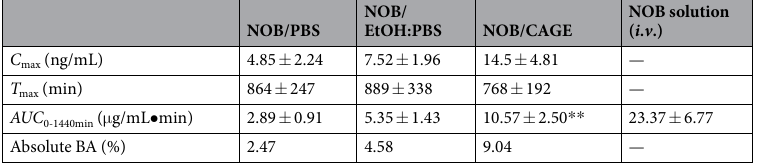
Table 2. Pharmacokinetic parameters of NOB. Mean ± S.E. ( n = 5). The inter-group comparison was carried